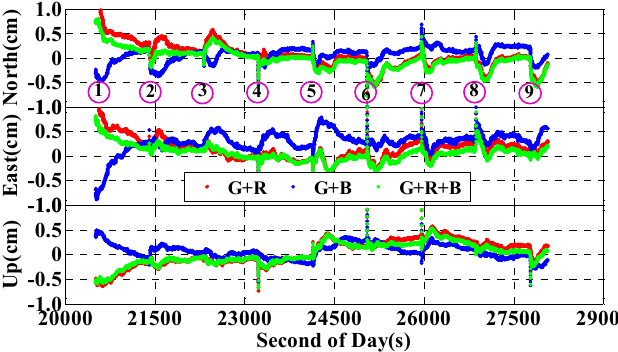
Remote Sens. 2016 , 8 , 553